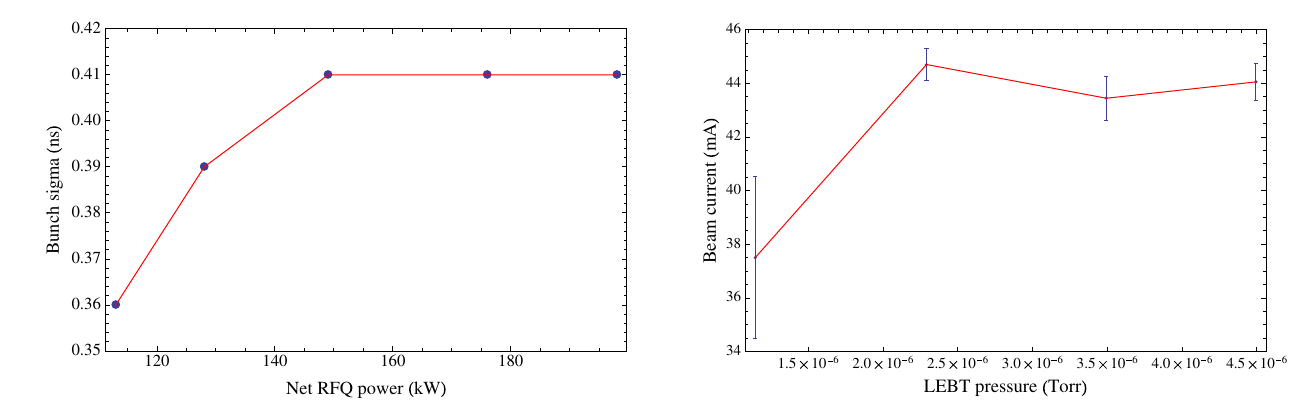
FIG. 31. The output current of the RFQ as a function of LEBT pressure. Under 2 × 10 − 6 Torr the gas focusing is not strong enough to overcome space